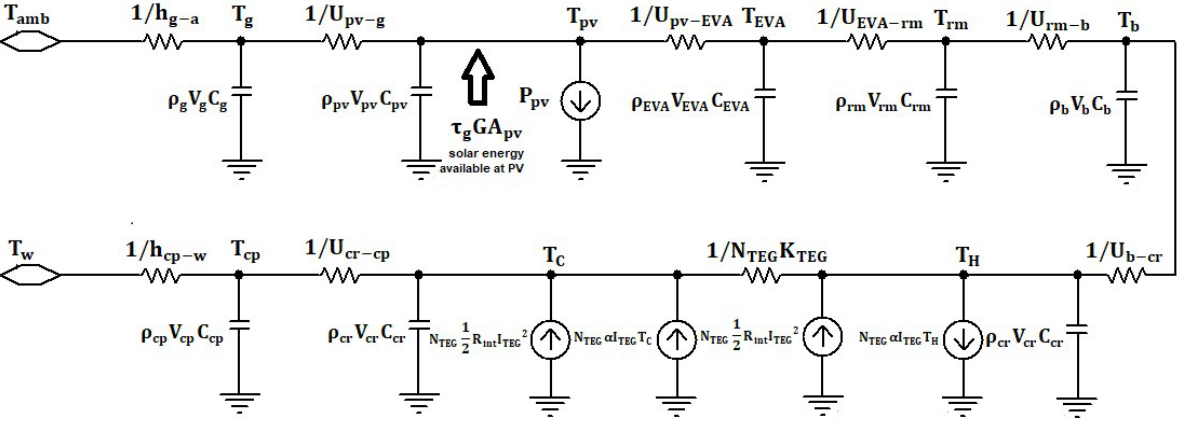
Figure 4. Thermal module of hybrid PVTEG system. Table 2. Design parameters of PV and thermos physical properties of the layer [21].